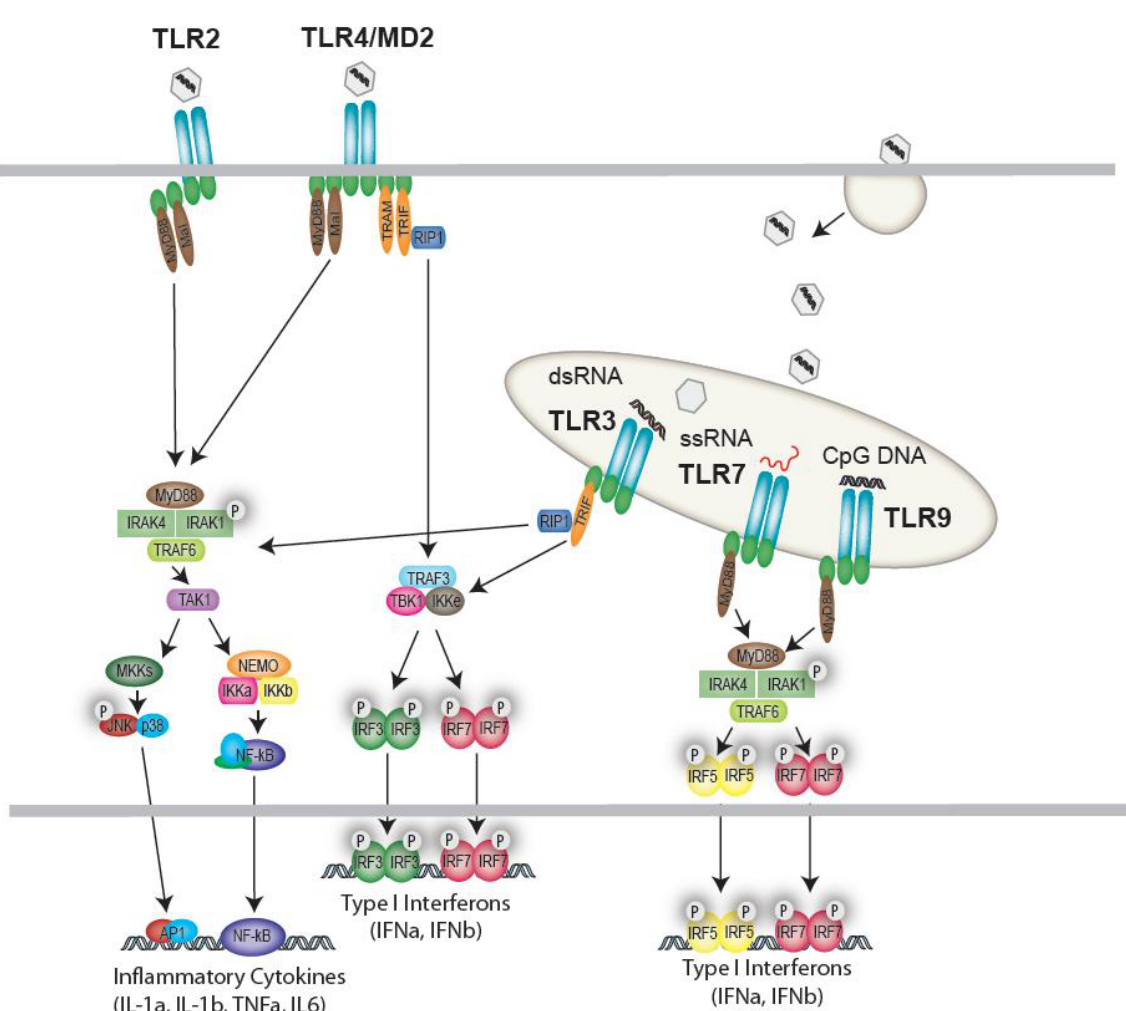
Figure 1. Cell surface and endosomal recognition of viruses by Toll-like receptors